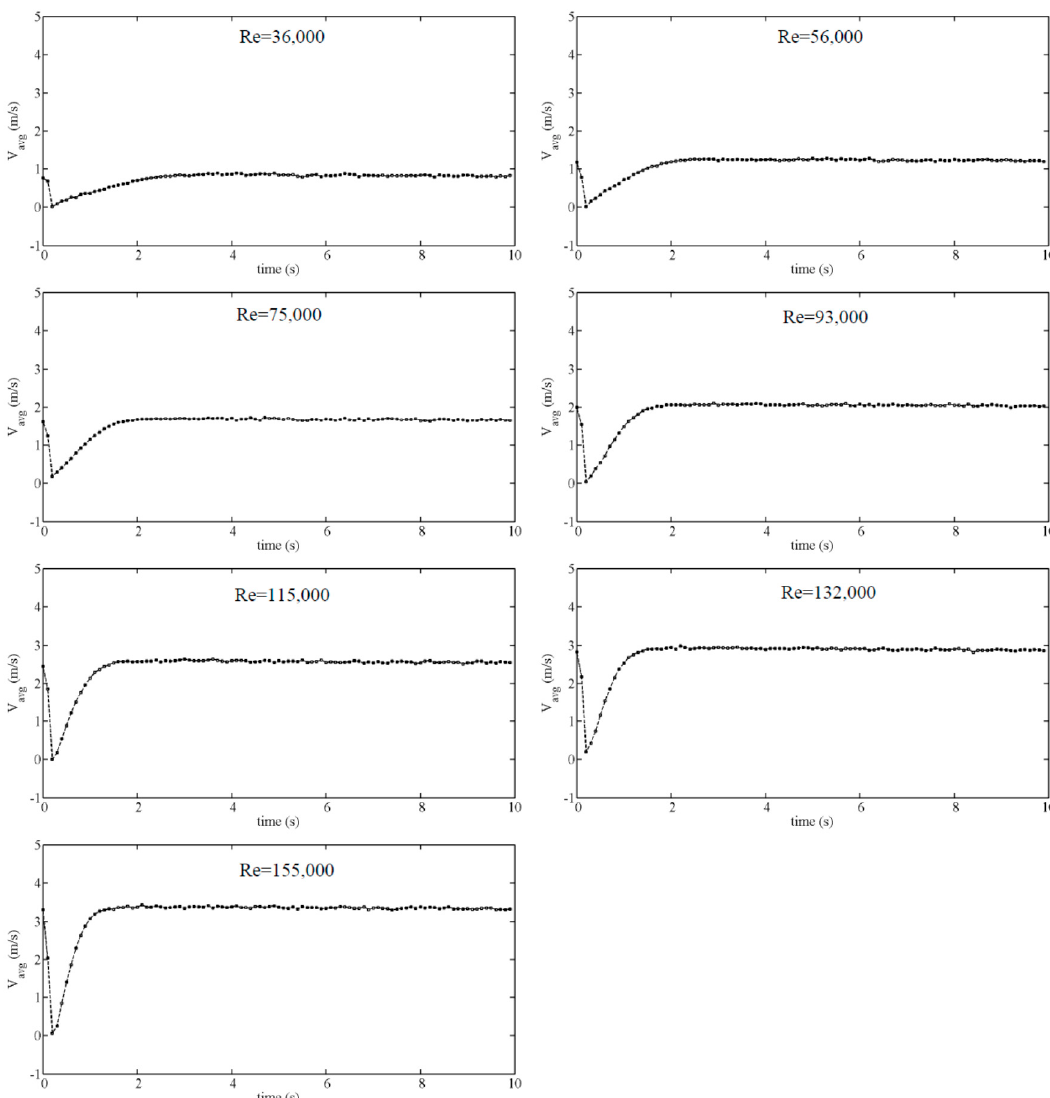
Figure 10. Average velocity for different Re during 1WH tests.